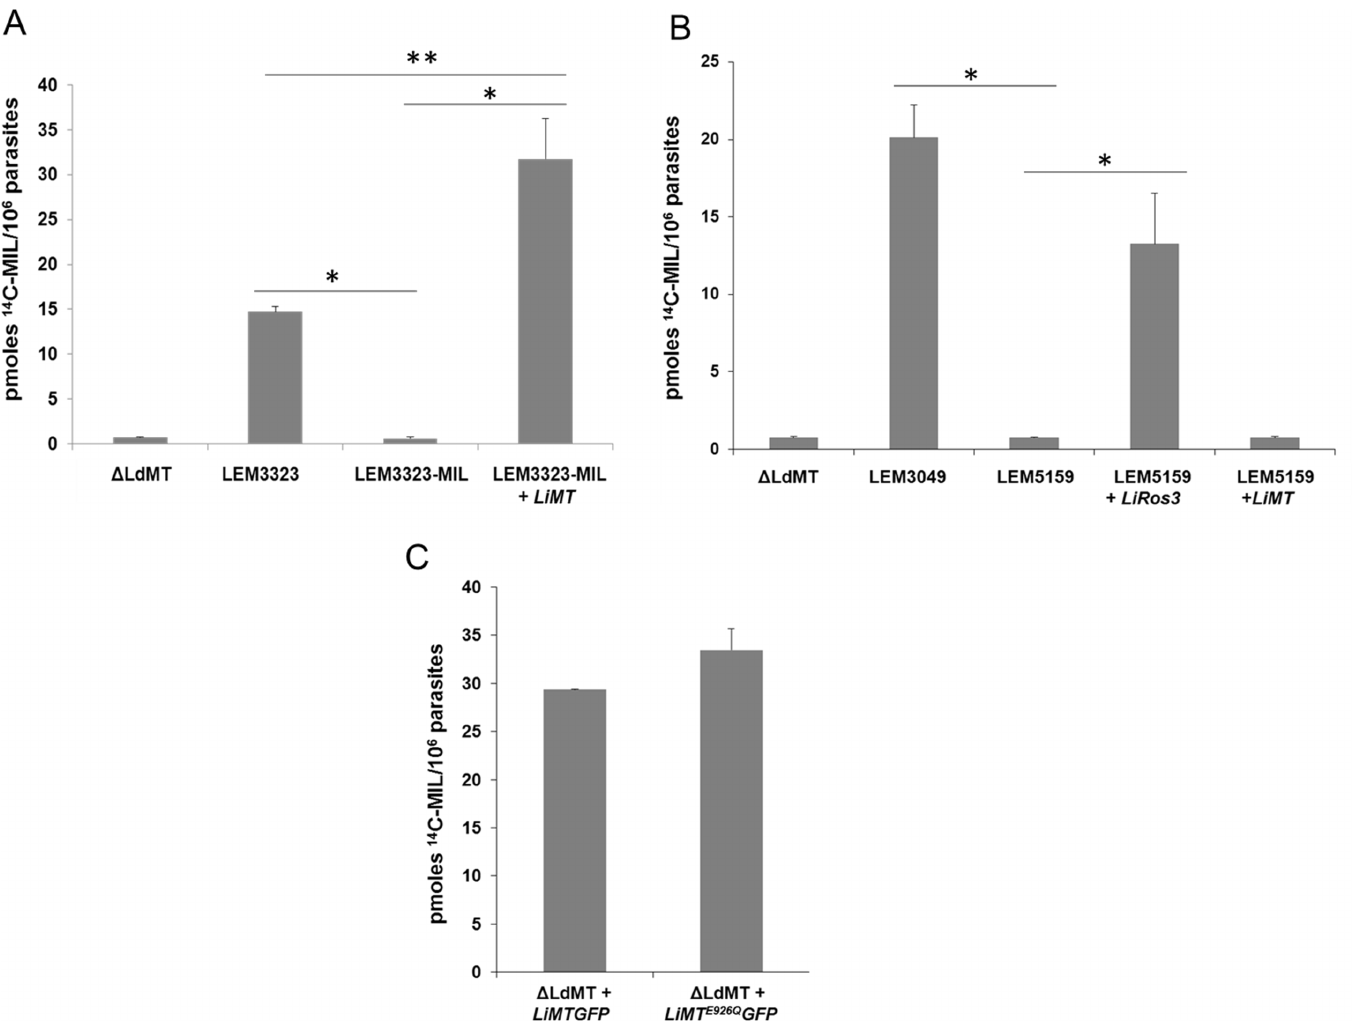
Fig 1. Determination of intracellular MIL-accumulation. Uptake of [ 14 C]MIL by L . infantum and L . donovani promastigotes was measured after incubation for 60 min at 28°C (A-C). Results are expressed as the mean ± the standard deviation of three independent experiments in duplicate. (A) L . donovani Δ